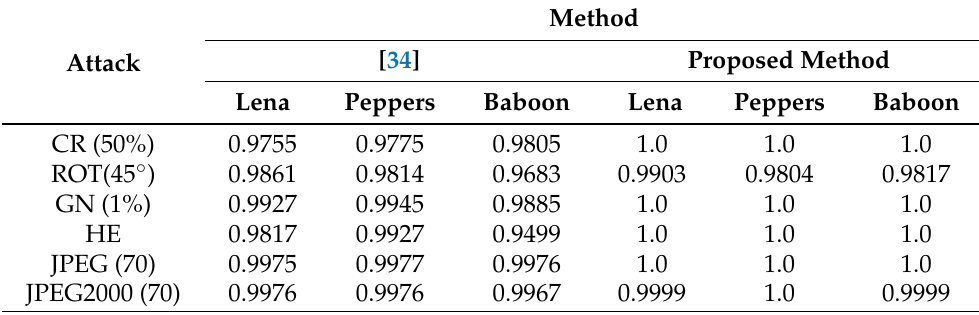
Table A5. Robustness comparison with [34] measured in terms of NC for Lena, Peppers, and Baboon